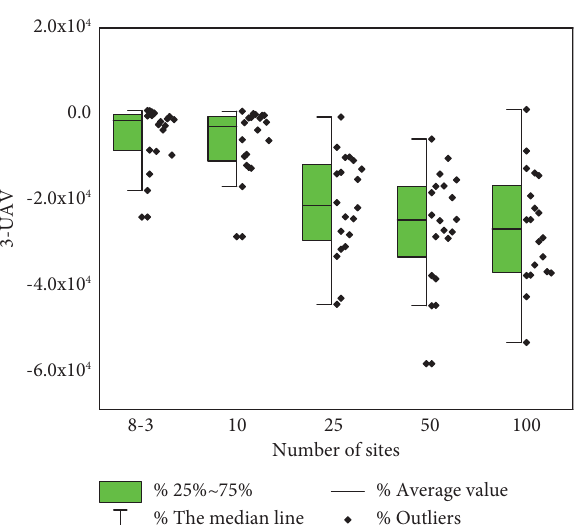
Figure 14: 3-UAVs time saving